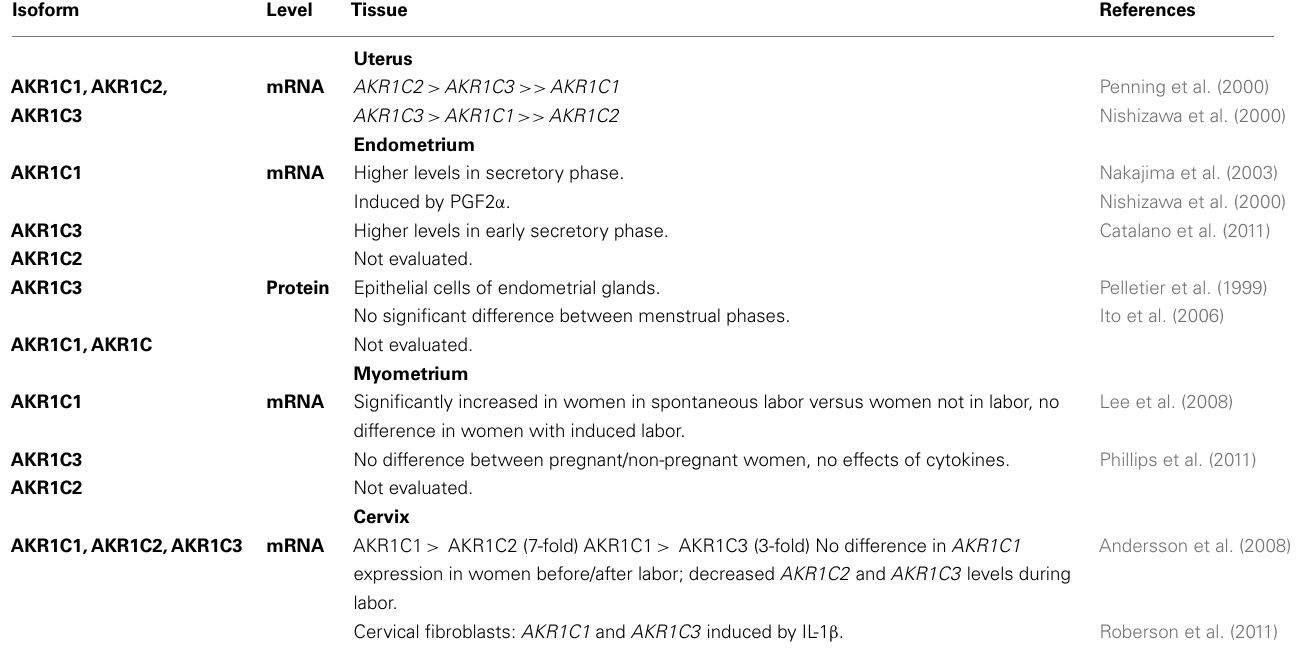
Table 5 | Expression of AKR1C1 , AKR1C2 , and AKR1C3 in human